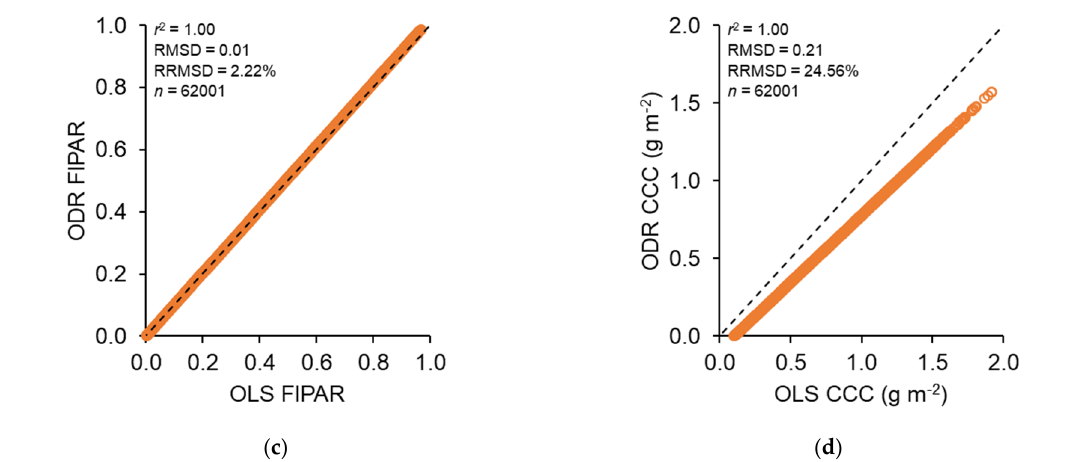
Figure 12. Comparison between ODR- and OLS-based high-spatial-resolution reference maps of FIPAR ( left ) and CCC